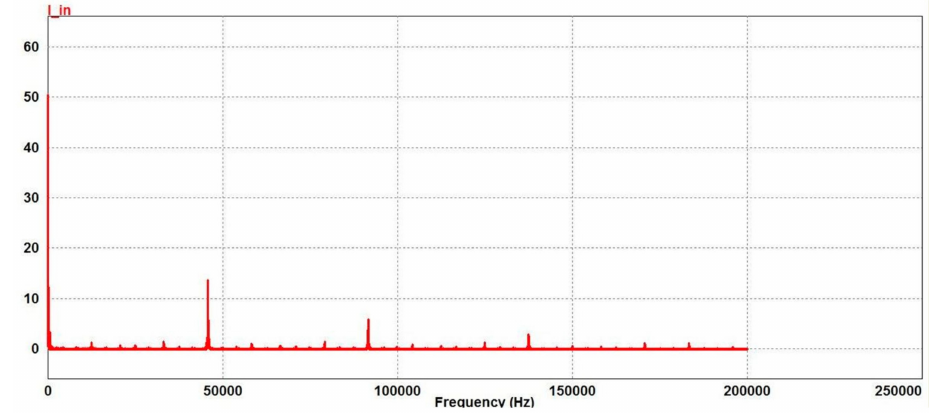
Figure 9. FFT of the input phase current of the IH equipment without an LPF.